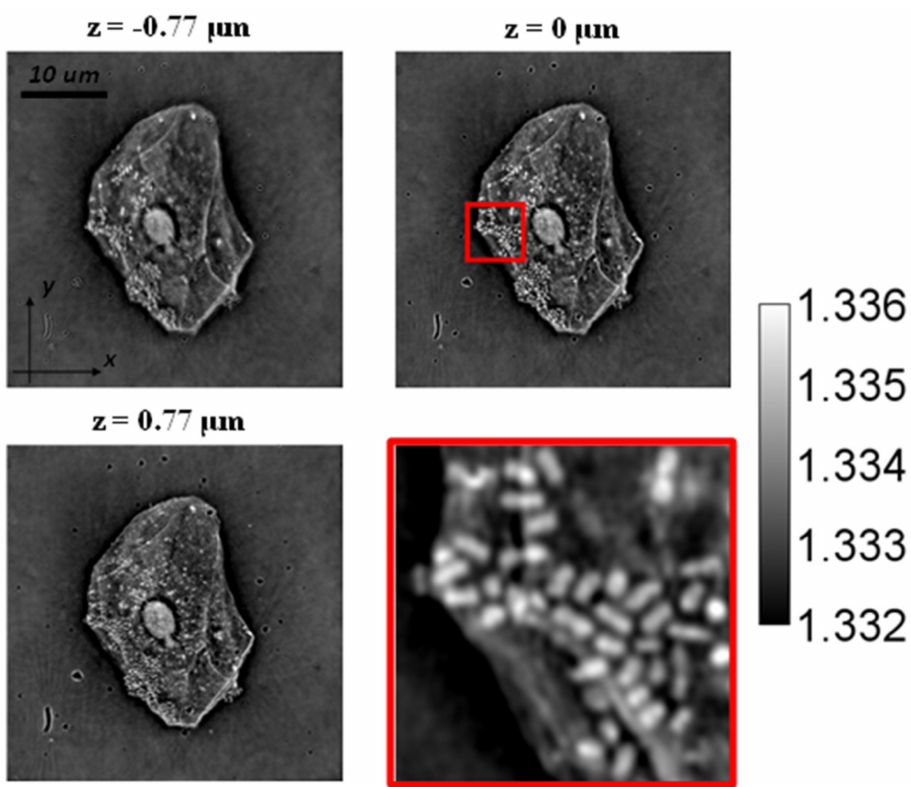
Figure 6. 3D RI reconstruction at different depths. The red box is a magnified picture of the highlighted red region. It shows the higher refractive index of this bacterial structure as compared to the cytoplasm of the